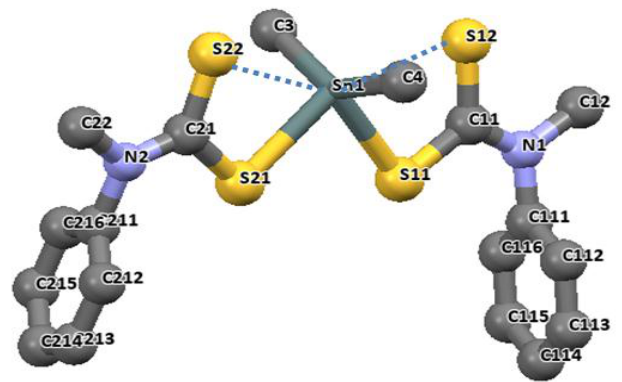
Figure 10. Molecular structure of dimethyltin(IV) complexes of N -methyl- N -phenyldithiocarbamate [(CH 3 ) 2 SnL 2 ]. (For clarity, H atoms were omitted). Redrawn from [86], with permission from Elsevier (Copyright 2018).